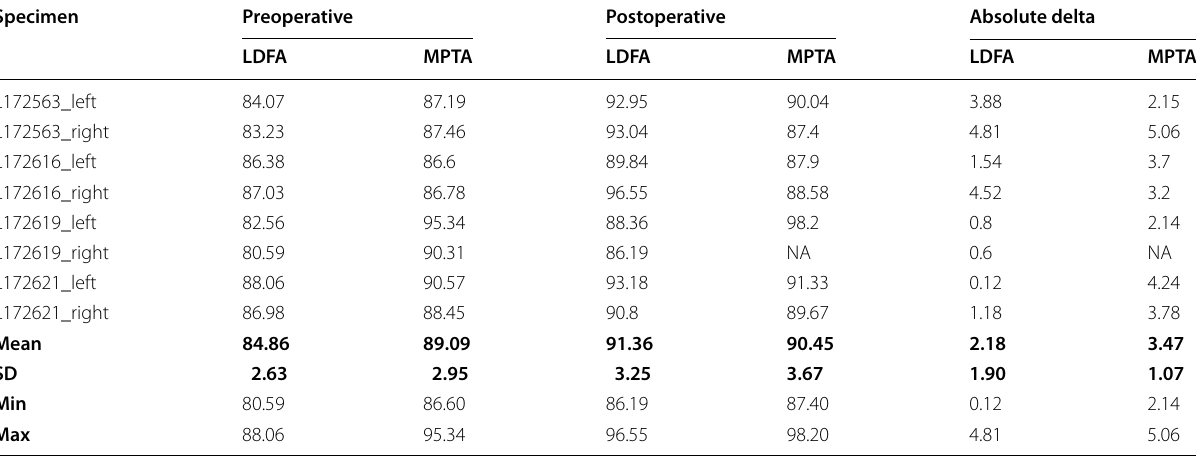
MPTA media proximal tibial angle, LDFA lateral distal femoral angle